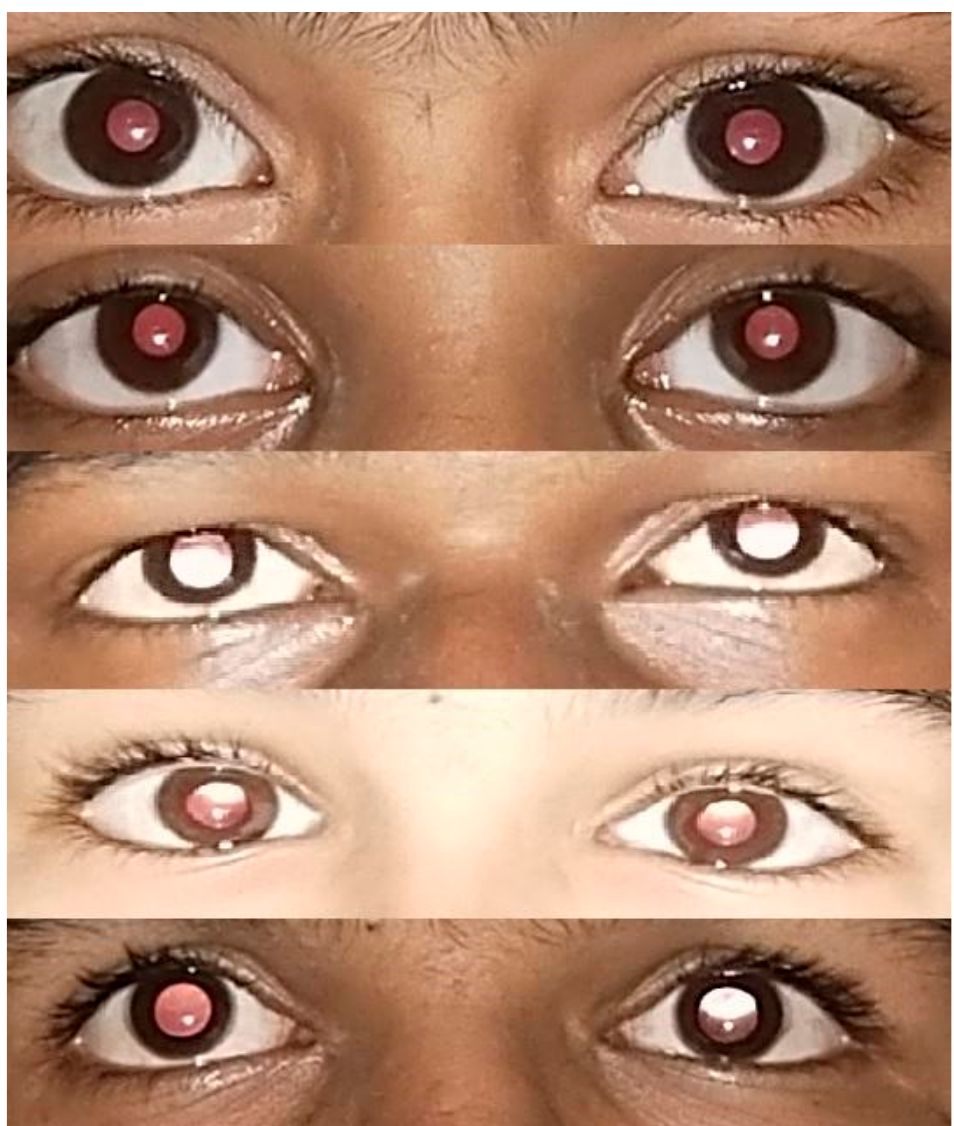
Figure 5. Representative photographs from the sample (top to bottom) 1. Emmetropia 2. Emmetropia 3. Myopia (RE − 4.5 DS, LE − 3.5 DS) 4. Hypermetropia (RE + 2.0 DS/+1.0 DCyl @ 70, LE + 2.5 (RE = right eye, LE = left eye, DS = Dipotre Sphere, DCyl = Dioptre Table 2. Sensitivity and specificity of detecting ocular morbidities using unanimously graded smartphone photographs. Figures in italics represent the sensitivity and specificity.